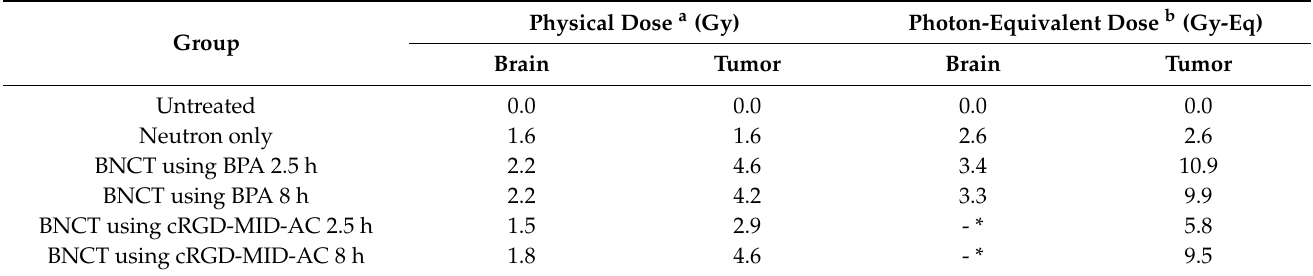
Table 3. Physical and estimated photon-equivalent doses for brain or tumor in F98 glioma-bearing